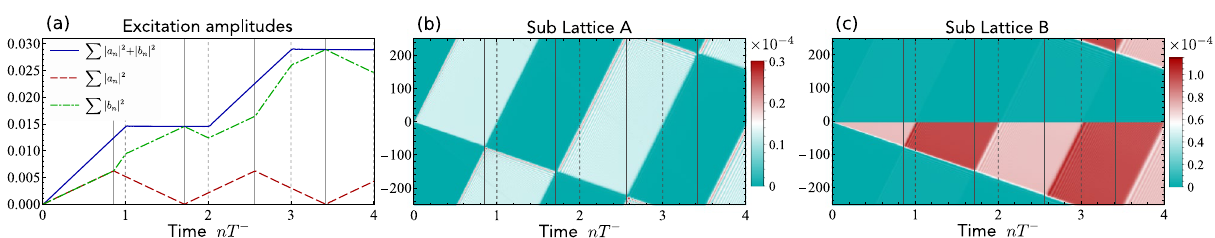
Figure 3. (color online) ( a ) Temporal evolution of the total excitation amplitude relative to sublattices A and B for in the intermittent decay blockade regime ( N evolution of the excitation amplitudes in sublattices A and B on a pseudocolor map (see the “Methods” for the definition of such amplitudes) . In each plot, vertical lines corresponds to times (solid) at which slow and fast waves meet and to times (dotted) at which the fast one make a complete